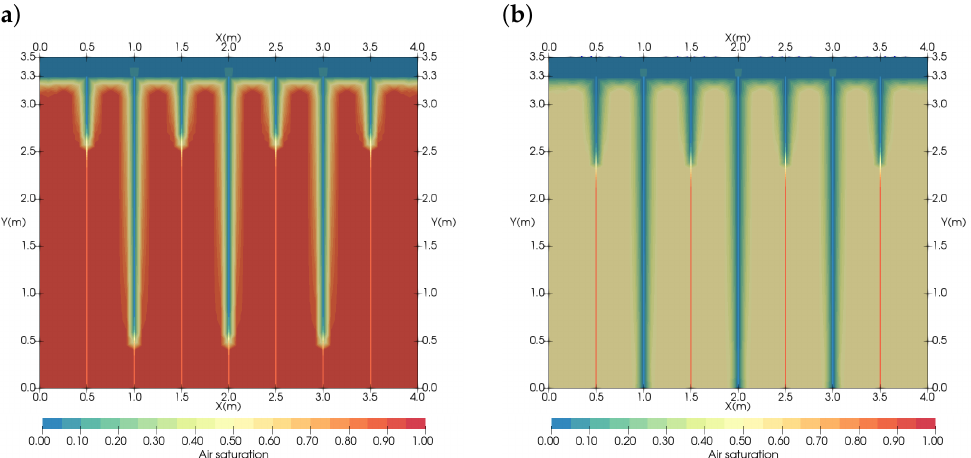
Figure 17. Air distribution in model TUFF2D after ten minutes corresponding to a high precipitation rate scenario (case B). ( a ) low initial water saturation, ( b ) high initial water saturation. Figure 18 displays co- and counter-current flows in detail, revealing that the flow pattern is essentially the same for the 1.1 and 0.5-mm wide fractures: air and water move in the same direction ahead of the wetting front. Behind the wetting front counter-current flow of water and air